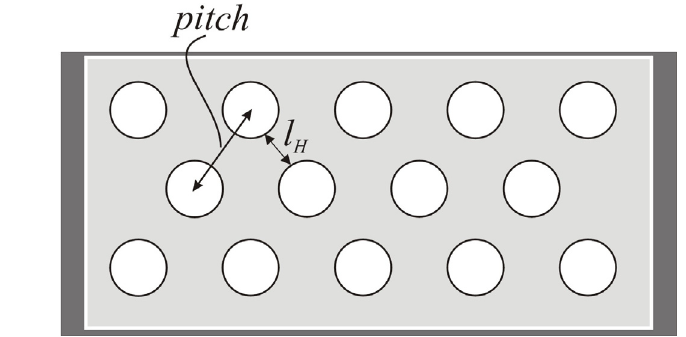
Figure 16. Parameters for the ligament efficiency in RF MEMS switch membrane with through